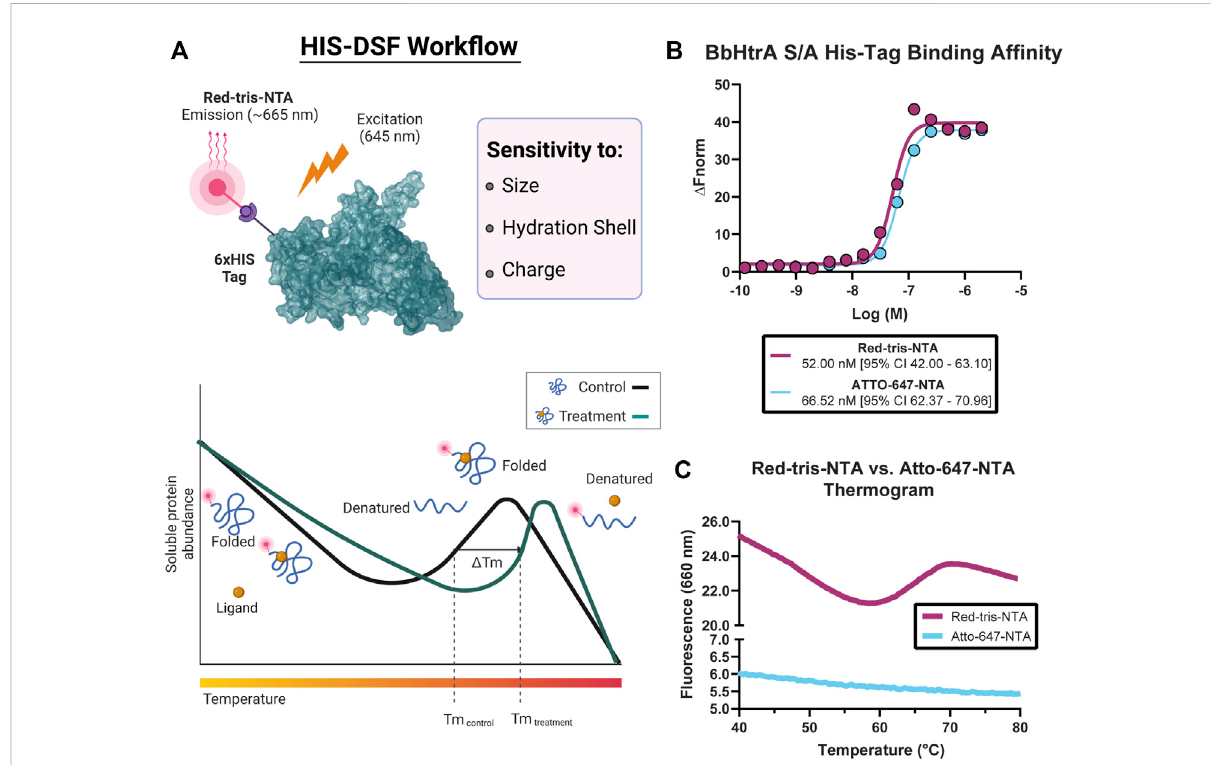
FIGURE 1 Overview of the histidine-tagged differential scanning fl uorimetry assay (HIS-DSF). (A) Schematic representation of the His-tagged protein of interest labeled speci fi cally by the Red-tris-NTA fl uorophore by the Ni(II)-nitrilotriacetic acid (NTA) moiety (top) and the design and work fl ow of the HIS-DSF assay (bottom). (B) Evaluationoftheaf fi nityfor theNTA- fl uorophores towardsHIS-tagged BbHtrAS/A byMST. (C) Testing HIS-tag directed fl uorophores in a differential scanning fl uorimetry experiment. Labeled protein (as described in the Materials and Methods section)was run in a standard DSF melting experiment to check for the presence of melting